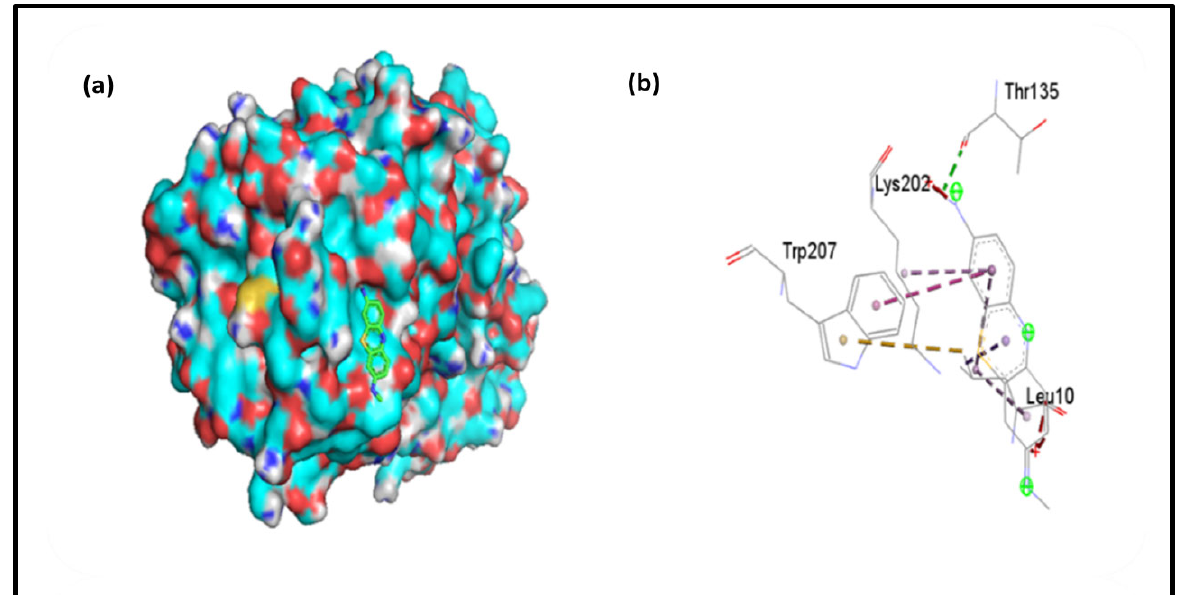
Figure 7. ( a ) 3D representation of Binding of AzC with Chymo, ( b ) 2D picture of AzC with Chymo ‐ trypsin.